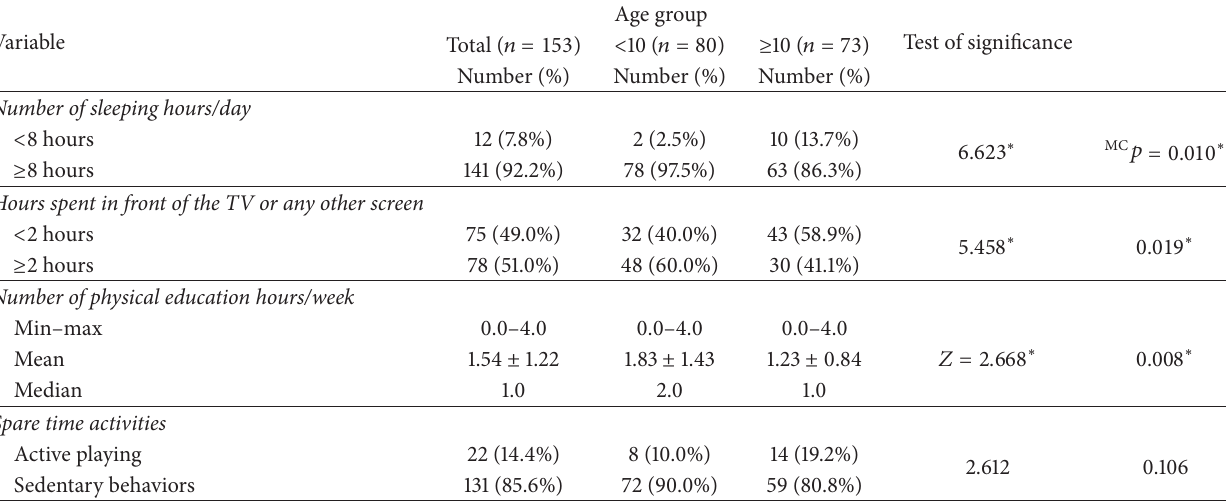
Table 4: Physical activity and sedentary